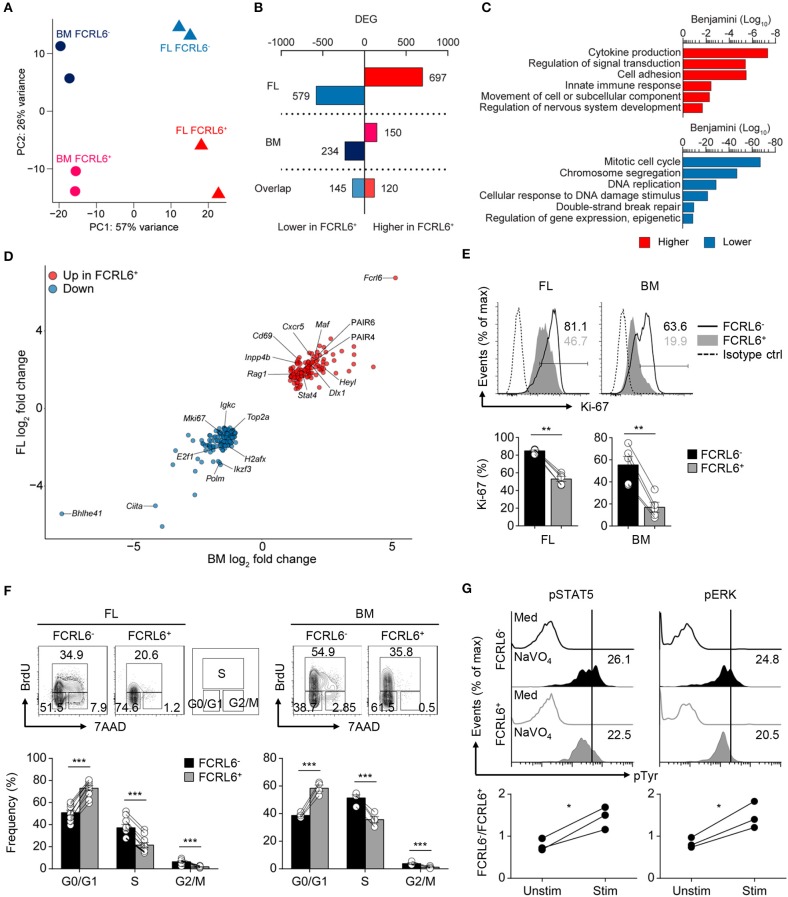
Transcriptomic and biologic heterogeneity of pro B cells. (A) Principal component (PC) analysis of RNA-seq performed on duplicate FL and BM FCRL6+ and FCRL6− pro B cell samples sorted by flow cytometry as in Figure 1B. (B) Quantitation of differentially expressed genes (DEG) relative to FCRL6+ cells by tissue defined by a change in expression of 1-fold (log2 value) and FDR (<0.05). (C) Gene ontogeny (GO) pathways derived from FL DEGs. (D) Scatter plot of overlapping DEGs. Results are presented as the difference in expression (log2 transformed values) of FCRL6+ relative to FCRL6− pro B cells from the FL (vertical) and BM (horizontal). (E) Intracellular staining and flow cytometry analysis of Ki-67 among pro B cell subsets (n = 5 each). Percentages of gated cells relative to an isotype-matched control are indicated in the histograms and summarized below. (F) Proliferation and cell cycle status of FL (n = 10) and BM (n = 4) pro B cell subsets assayed by staining with the thymidine analog BrdU and 7-AAD DNA intercalation dye before flow cytometry analysis. The percentages of G0/G1, S, and G2/M phase cells are shown adjacent to the contour plot gates and are summarized below. (G) Phospho (p)-flow cytometry analysis of sorted FCRL6+ and FCRL6− BM pro B cells either unstimulated (medium) or stimulated with sodium pervanadate (NaVO4) for 10 min ex vivo. Cells were intracellularly stained with control Abs or those specific for pSTAT5 and pERK. Values in the histograms represent MFI ratios (test Ab MFI/control Ab MFI). Fold differences comparing FCRL6− and FCRL6+ pro B cells are shown below. Each symbol (E–G) represents an individual mouse. Small horizontal lines (E,F) indicate s.e.m. *P < 0.05; **P < 0.01; ***P < 0.001 as determined by paired Student's t-test. Data are from four independent sorts and two per cell type (A–D), one representative of two experiments (E,F), and three independent experiments (G).